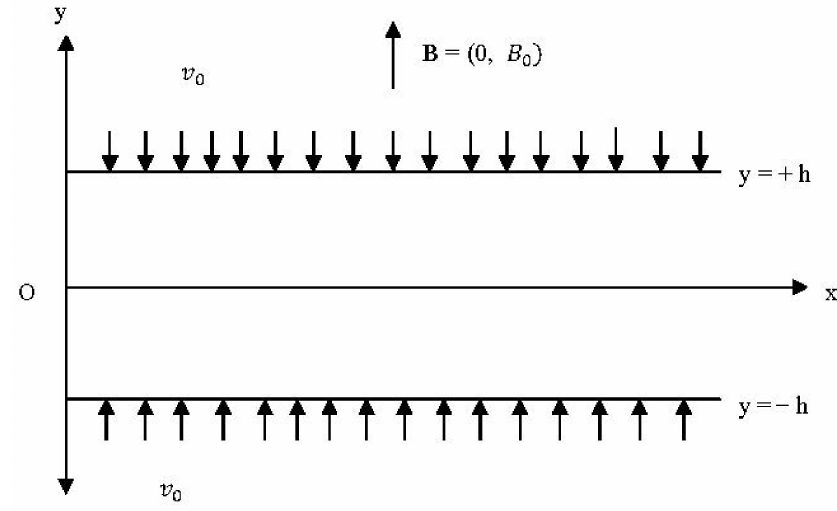
Figure 1. Geometrical view of the